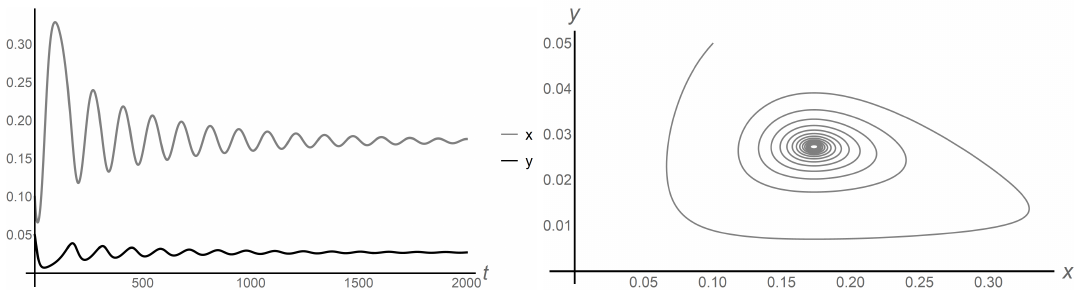
Figure 2. Left panel : trajectories of the prey and predator populations from model (1) towards the internal equilibrium E ∗ (0.1734, 0.0273). Right panel : the corresponding phase plane portrait. Parameter values: r = 0.18, α = 2.5; all the other values as in Table 1.